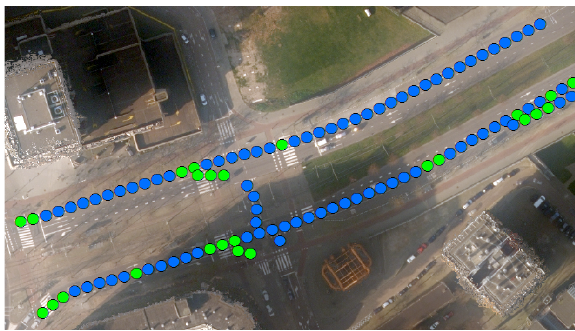
Figure 6. Test area 2; green: recording locations with correspondences to the aerial images; blue: recording locations without